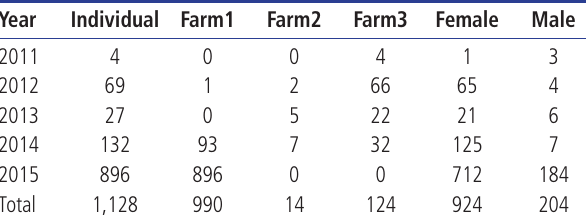
Table 1. Information of Landrace population (1,128 individuals) in this